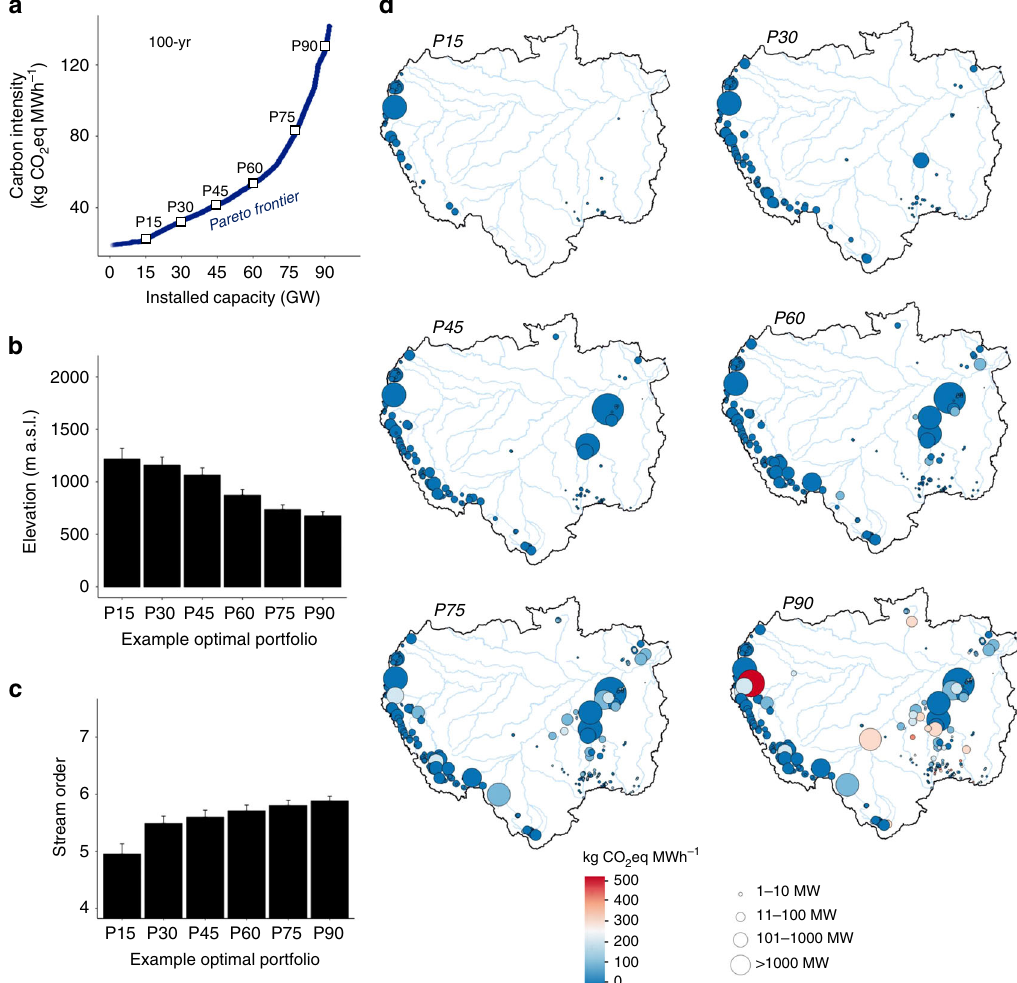
Fig. 3 Characterization of optimal dam con fi gurations as electricity generation increases. a Carbon intensity outcomes (100-year time horizon) of optimal dam portfolios for different values of installed capacity considering the 351 proposed Amazon dams; squares indicate six example reference portfolios spanning increasing installed capacity (P) from 15 – 90 GW. The mean (±s.e.m.) elevation ( b ) of dams decreases, and stream order at dam locations ( c ) increases, as optimal portfolios target greater total installed capacity and subsequently include more dams in lowland areas of the Amazon basin ( d ). Stream order is a metric used in hydrology to indicate the level of branching in a river network, where increasing stream order correlates with